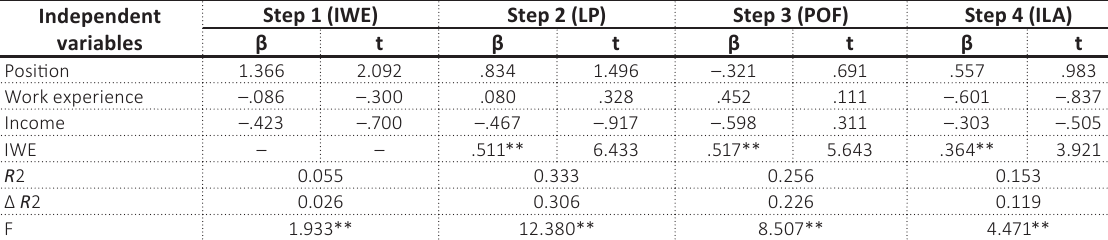
Table 4. Hierarchical regression analysis of IWE on person-organization fit (POF), innovation in learning activities (ILA), and lecturer performance (LP)